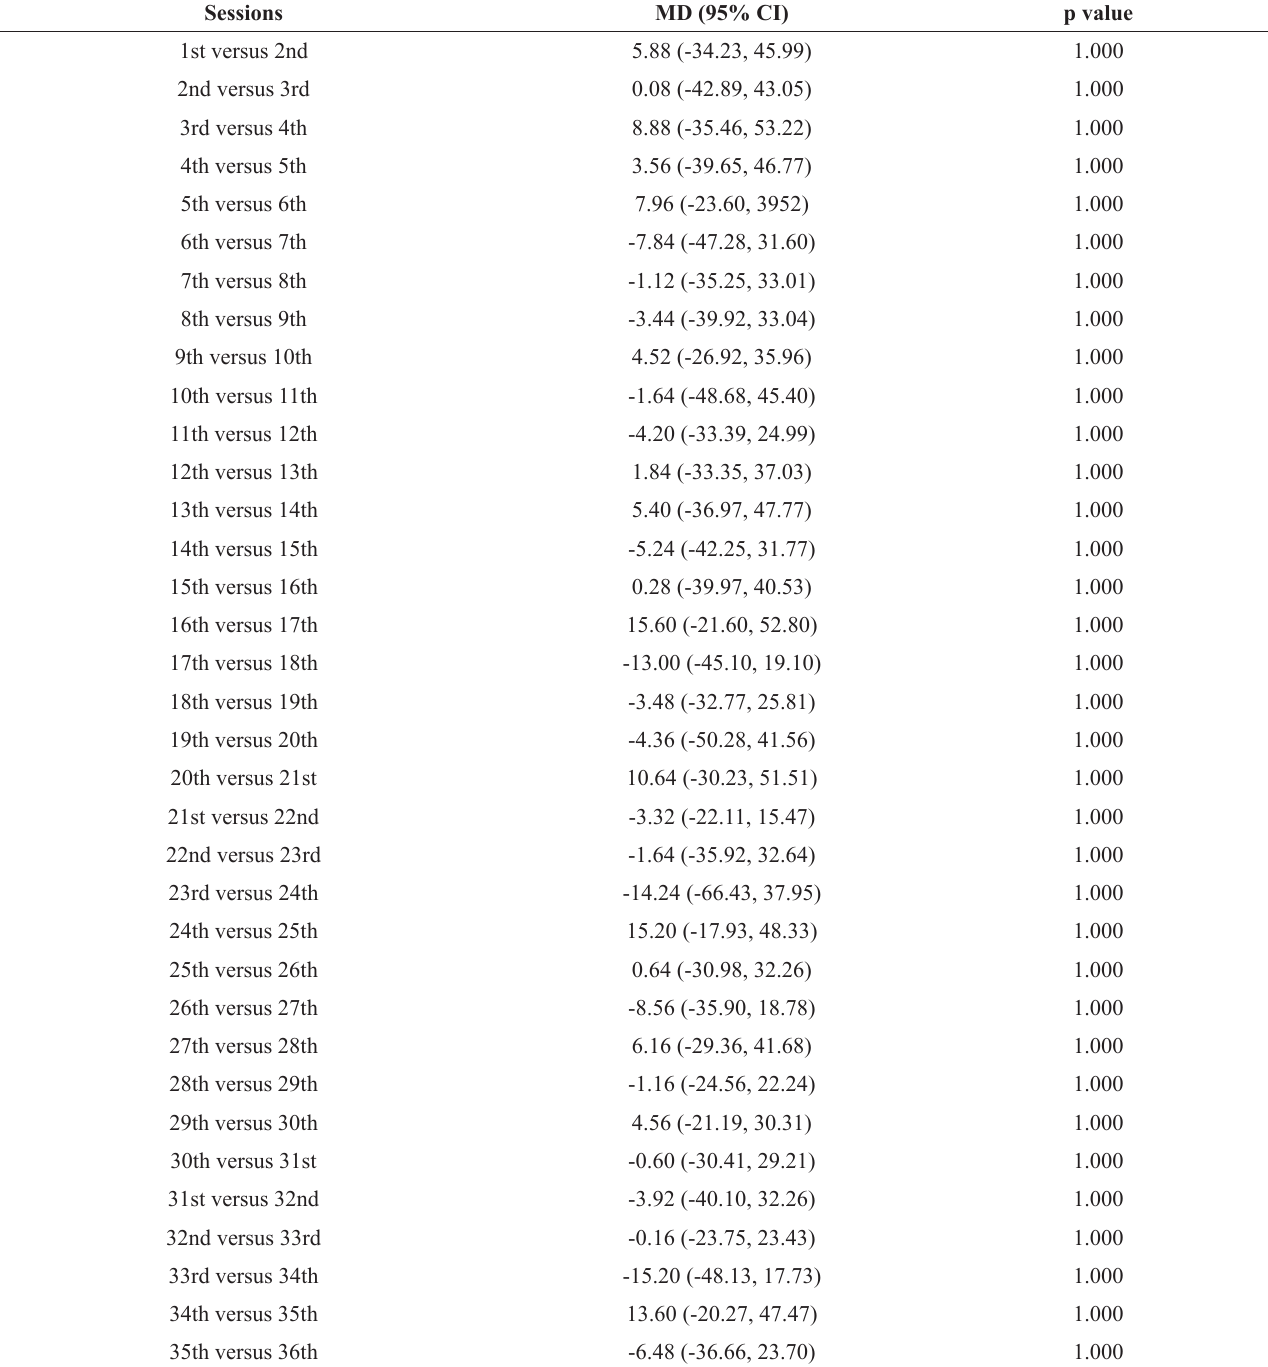
Table 4. Comparison of blood glucose values (mg/dL) after each session of strength and aerobic training program. Sessions MD (95% CI) p